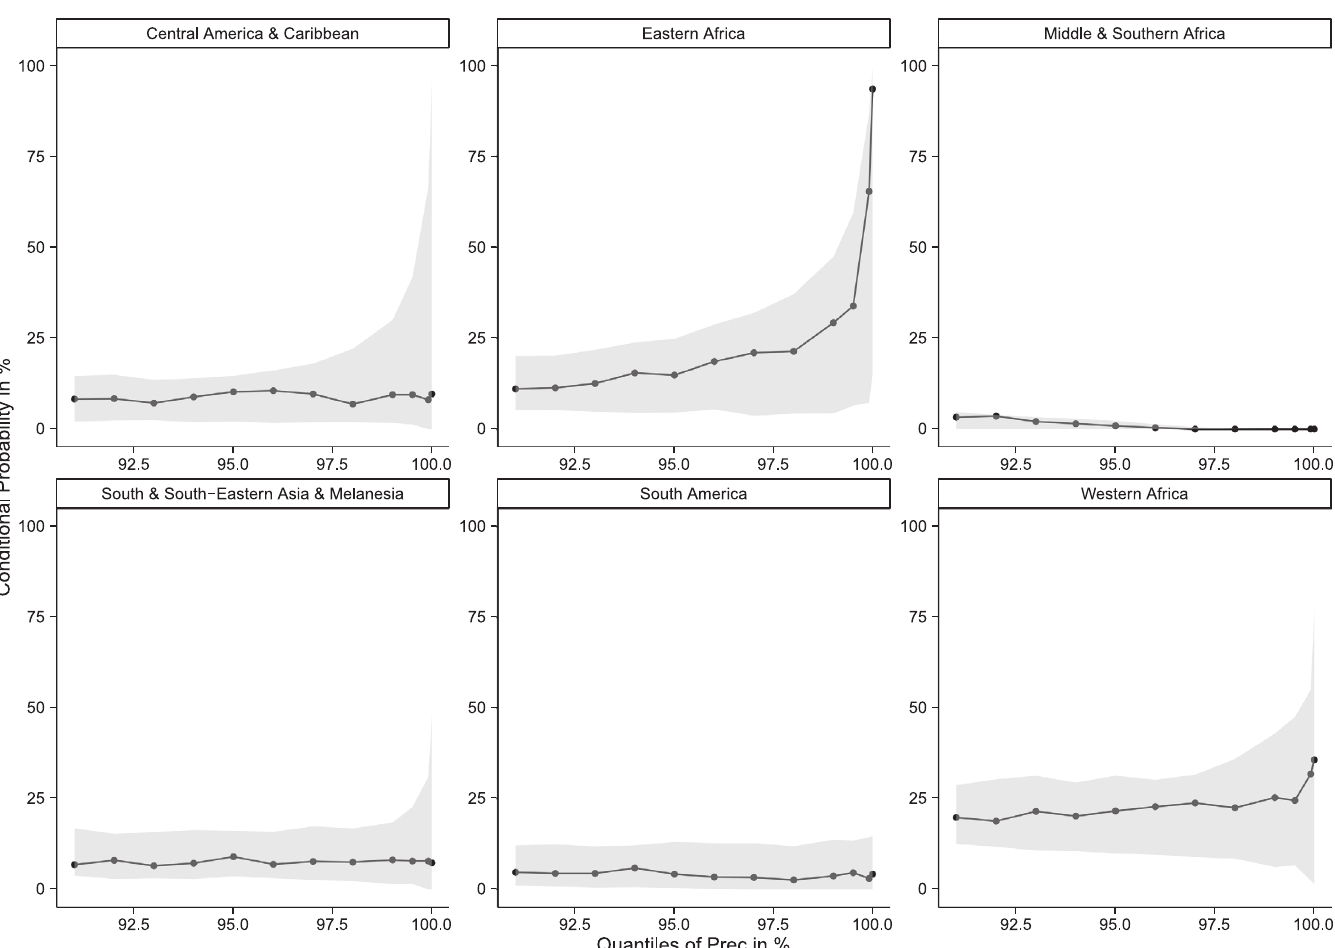
Fig 3. Point estimates and 95% confidence intervals of the conditional probability P ( YieldRefl > qu YieldRefl | Prec > qu Prec ), where qu YieldRefl is always set as the 90 th quantile of the variable YieldRefl and qu is the 91 st to 99,99 th quantile of the conditioning variable Prec . Estimation is done using maize data from 1961 to 2002. Prec In Eastern Africa conditional probabilities sharply increase with widening confidence intervals for high thresholds of the conditioning variable. In Middle & Southern Africa the conditional probabilities or the lower confidence interval bounds are zero indicating no evidence of an association between extremes in high precipitation and high yield losses.